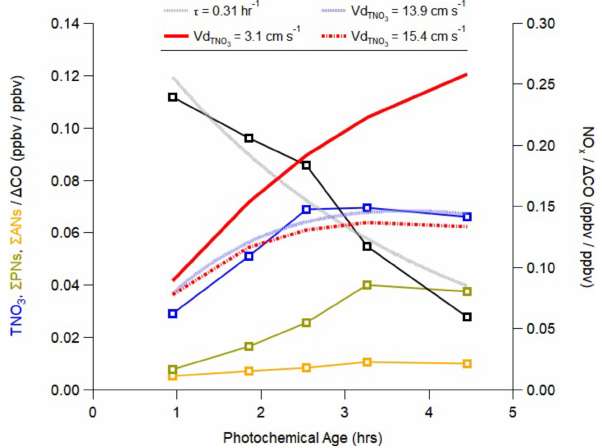
Figure 8. Plot of binned observations of NO x (right axis), total nitrate (TNO 3 = HNO 3 + pNO 3 ), sum of peroxy nitrates ( (cid:54) PNs), and sum of alkyl- and multi-functional nitrates ( (cid:54) ANs) (left axis for TNO 3 , (cid:54) PNs, and (cid:54) ANs) normalized to background- subtracted CO. The background CO from Nault et al. (2018) of 200ppbv was used. The photochemical age was calculated using propene and one of its photochemical products, propene hydroxyni- trate (Sect. S4). Data are binned between 0 and 5 equivalent hours between 11:00 and 16:00KST below 1km for the SMA (127 to 127.7 ◦ N, 37.2 to 37.7 ◦ N). The fit for NO x (dotted gray curve) is an exponential decay, leading to a first-order rate of 0.31h − 1 , which represents the loss of NO x via the production of oxidized com- pounds, such as TNO 3 . The best fit for TNO 3 ( t ) from Eq. (3) (dot- ted blue curve) includes this production and solves for first-order loss, which is assumed to be equivalent to the TNO 3 deposition rate (Sect. S4). Red curves represent solutions for TNO 3 ( t ) from Eq. (3), assuming different deposition velocities ( V d ) discussed in Sect.